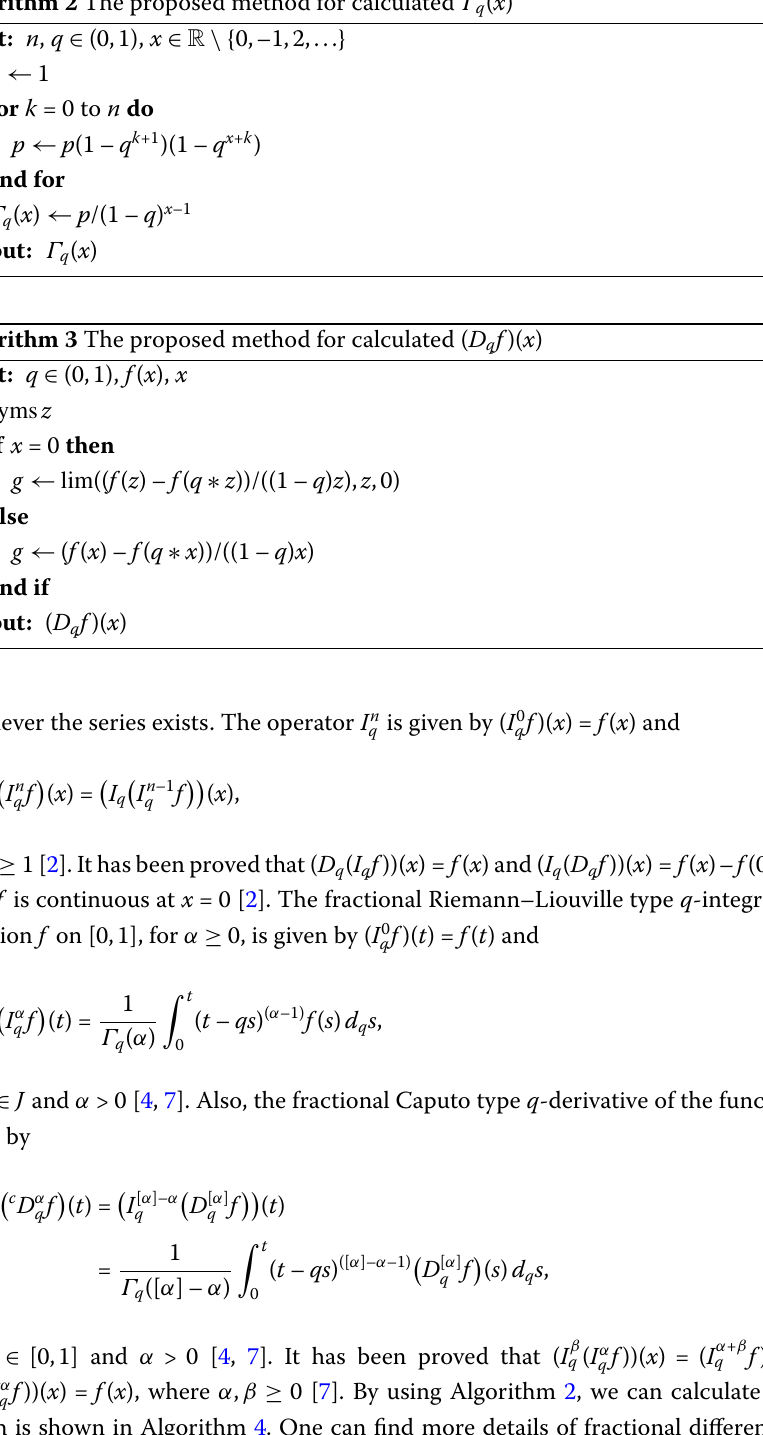
Algorithm 2 The proposed method for calculated Γ q ( x )